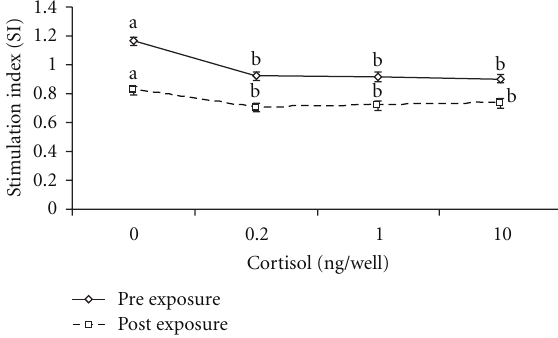
Figure 4: Stimulation index at di ff erent levels of cortisol in heat stressed bu ff aloes. Values are mean ± SEM. Bars with values in di ff erent groups that lack a common letter are significantly di ff erent ( P <